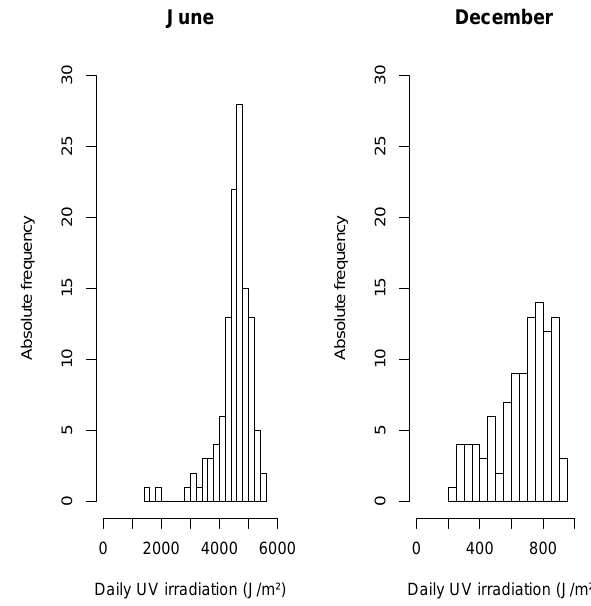
Fig. 9. Histogram of daily UVER values for June and